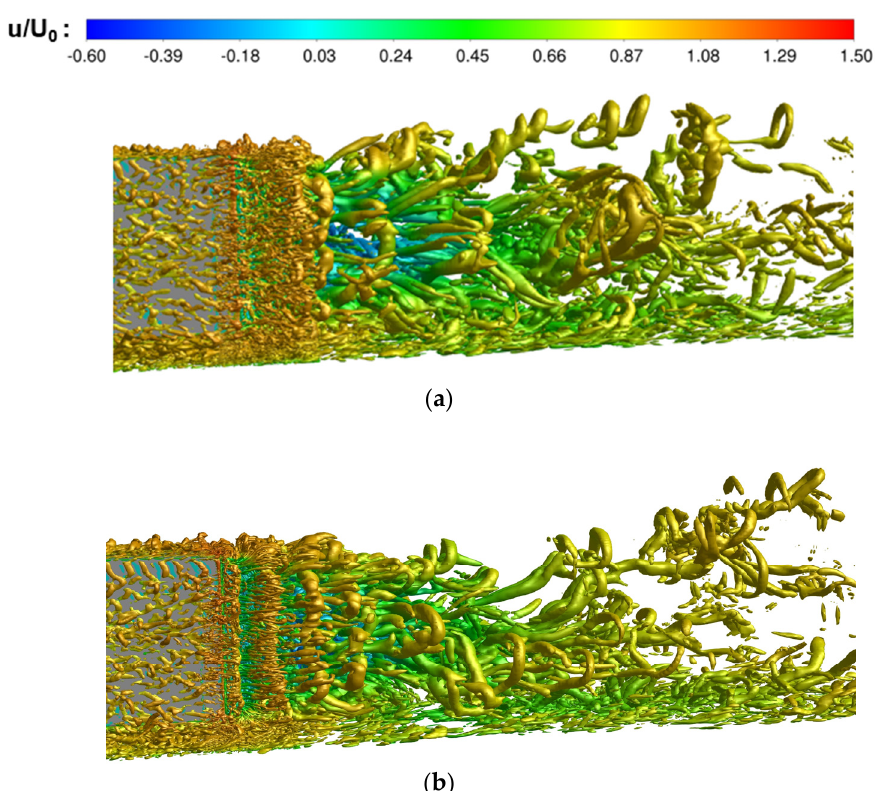
Figure 26. The normalized streamwise contour at the iso-surface Q = 300,000 s − 2 with the synthetic jet at different control frequencies. ( a ) fc = 68 Hz; ( b ) fc = 272